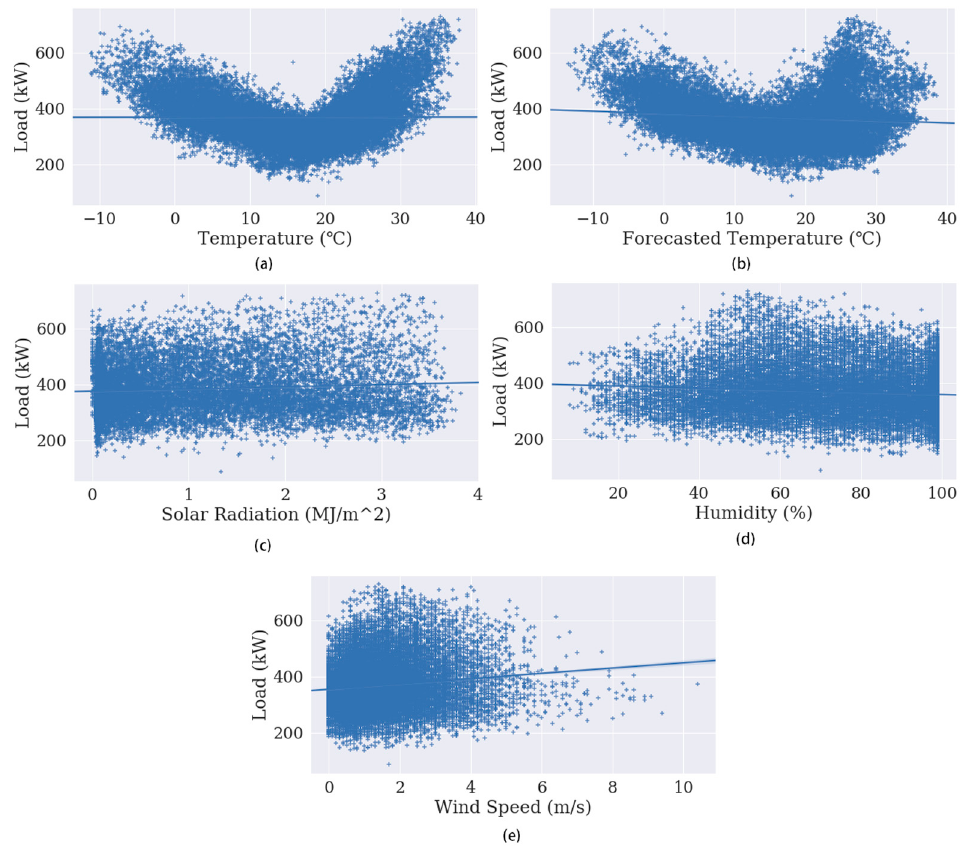
Figure 2. Relationship between load data and meteorological data: ( a ) temperature; ( b ) forecasted temperature; ( c ) solar radiation; ( d ) humidity; ( e ) wind speed.